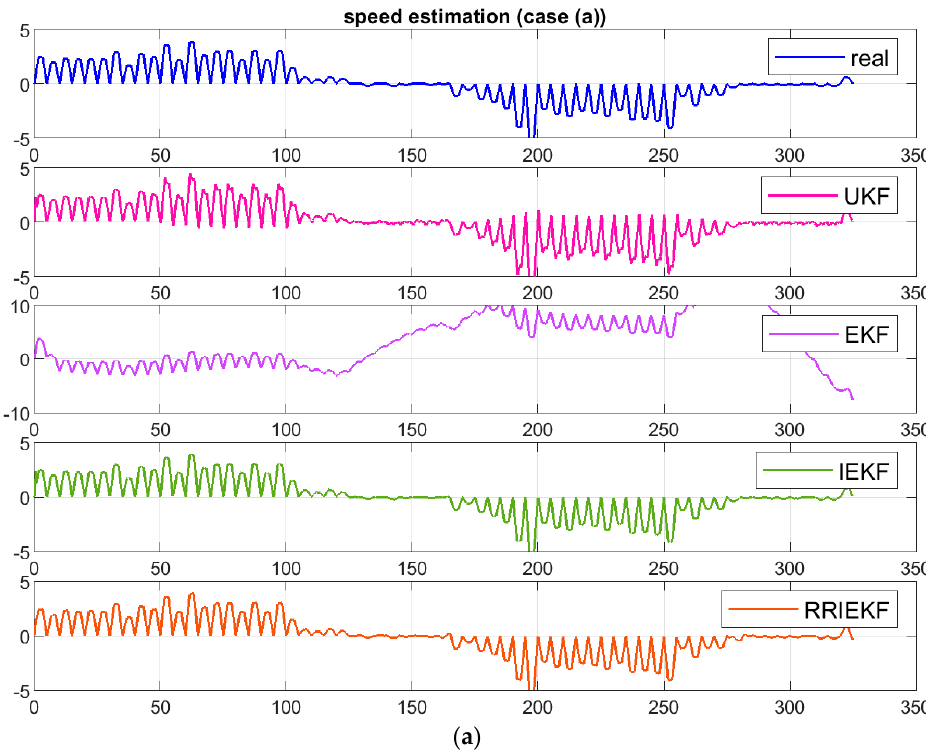
Figure 7. Position estimation error. Table 6. RMSE Position Errors.